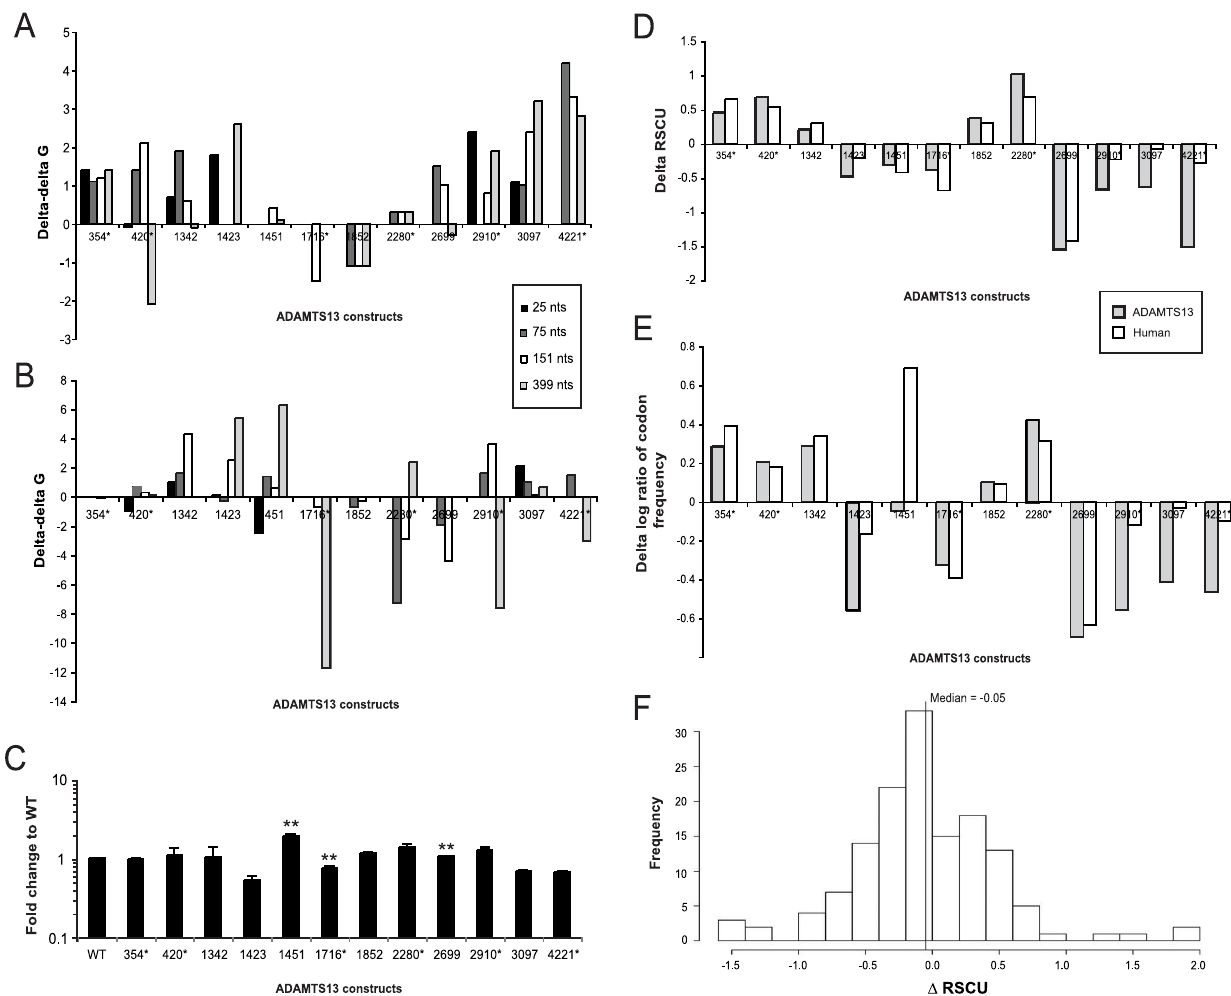
Figure 1. Analysis of mRNA structure/stability, codon usage and expression levels of ADAMTS13 variants: A. mFold DD G values of ADAMTS13 mRNA fragments: RNA fragments of 25, 75, 151, and 399 nucleotides in length were queried using online mFold server, utilizing default server settings. Variants were centered within the RNA fragments used in the analysis. The most stable structures (lowest D G) for both variant and WT ADAMTS13 variants were chosen. DD G ( D G variant - D G WT) was calculated and is displayed here for each of the variants. B. KineFold DD G values calculated using online KineFold server (obtained employing a similar strategy). C. ADAMTS13 mRNA expression levels as determined by qPCR: Analysis of mRNA expression was performed 24 h. post-transfection with quantitative real time PCR on WT ADAMTS13 and all twelve variants. GAPDH was used as a reference and a DD Cp was calculated using the average of all WT D Cp results for comparison. Fold change relative to WT is presented on a logarithmic scale. mRNA expression levels were analyzed in multiple independent transfection experiments utilizing each variant and WT ADAMTS13 variant, and found to be consistently similar from one experiment to the another (**p-value , 0.05). D. Differences in Relative Synonymous Codon Usage (RSCU) values between each of the ADAMTS13 variant codons and the WT codon: D RSCU= D (RSCUVariant – RSCUWT); the more positive is the D RSCU value, the more common is the variant codon compared to WT codon. RSCU values were calculated using the ADAMTS13 coding region and human codon usage information. E. Differences between log ratio of codon usage values for each of the ADAMTS13 variants and WT. The plotted values are the differences between log ratio of codon usage frequency of the variant and WT codon ( D (variant – WT)). The more positive the delta, the more commonly used the variant codon is, compared to WT. Values were calculated using the ADAMTS13 coding region and human codon usage information. F. Normal distribution of RSCU values for all variants in ADAMTS13 : The RSCU and log ratio of codon usage values were determined for all variants in the coding region of ADAMTS13 . MAD scores were assigned to the D RSCU and D log ratio of all variants. Comparison of MAD scores of twelve variants and all variants in ADAMTS13 revealed that D RSCU and D log ratio scores for the twelve variants fell within the distribution of variants in ADAMTS13 . ADAMTS13 variants harboring synonymous variants are marked with